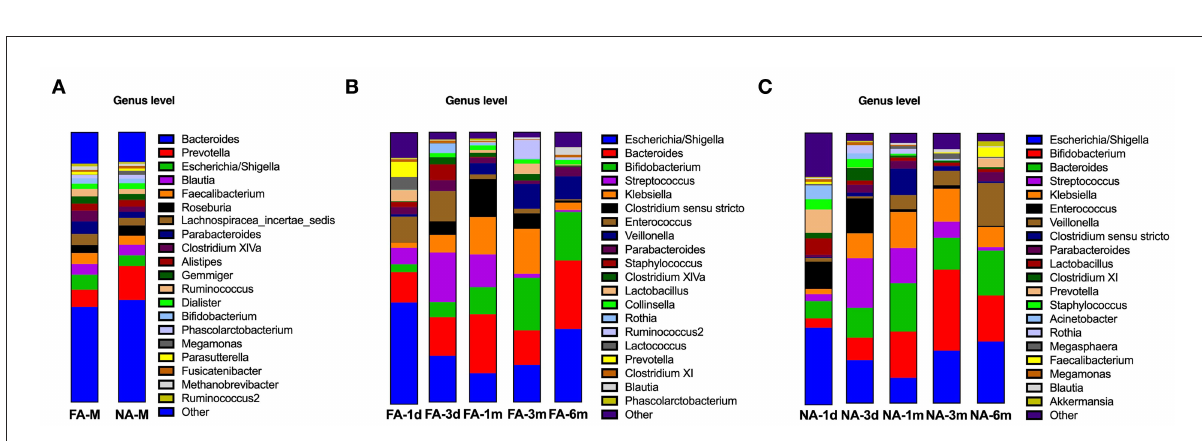
FIGURE7 Bacterial genera in maternal (A) and infant (B,C) participants in the non-allergy (NA) and food allergy (FA) groups.